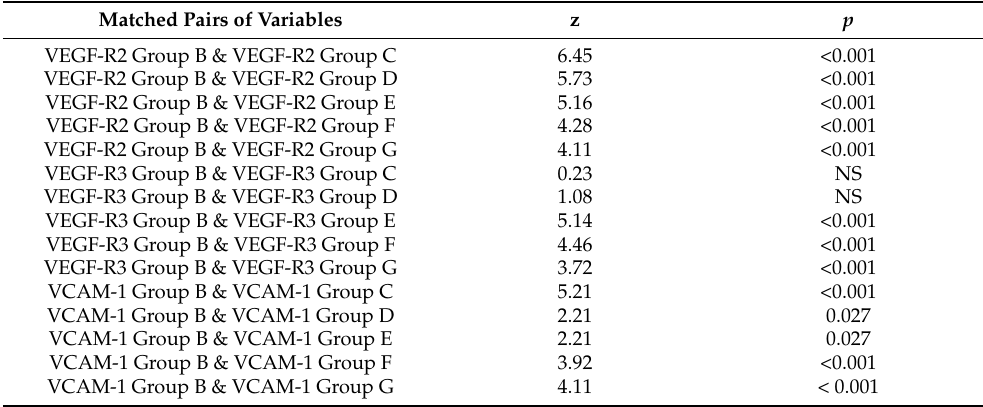
Table 3. The Wilcoxon matched pairs test of vascular endothelial growth factor receptor 2 (VEGF-R2), vascular endothelial growth factor receptor 3 (VEGF-R3), and vascular cell adhesion molecule-1 (VCAM-1) for SSAs-treated NET